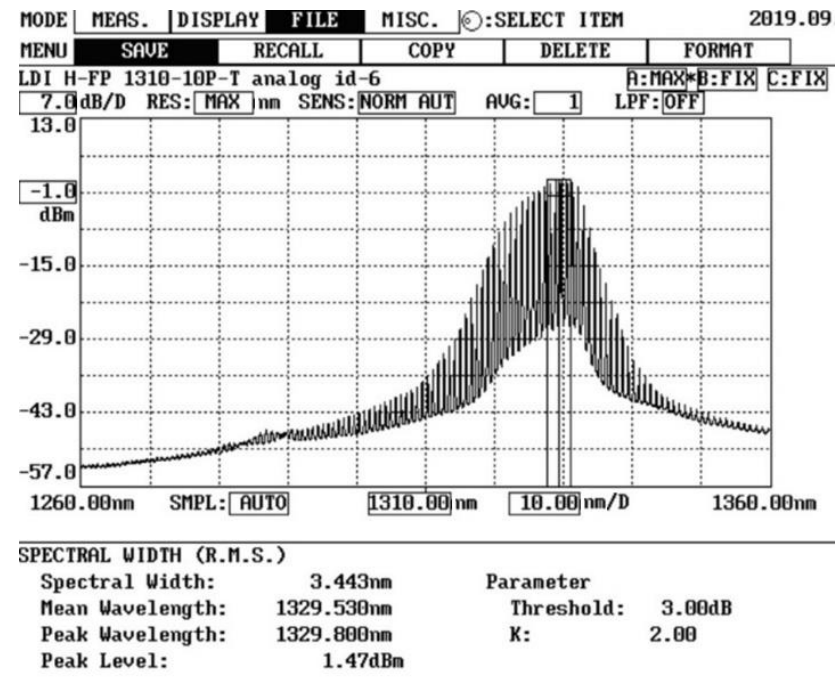
Figure 14. Optical spectrum of DMD analyzer Fabry-Perot LD.